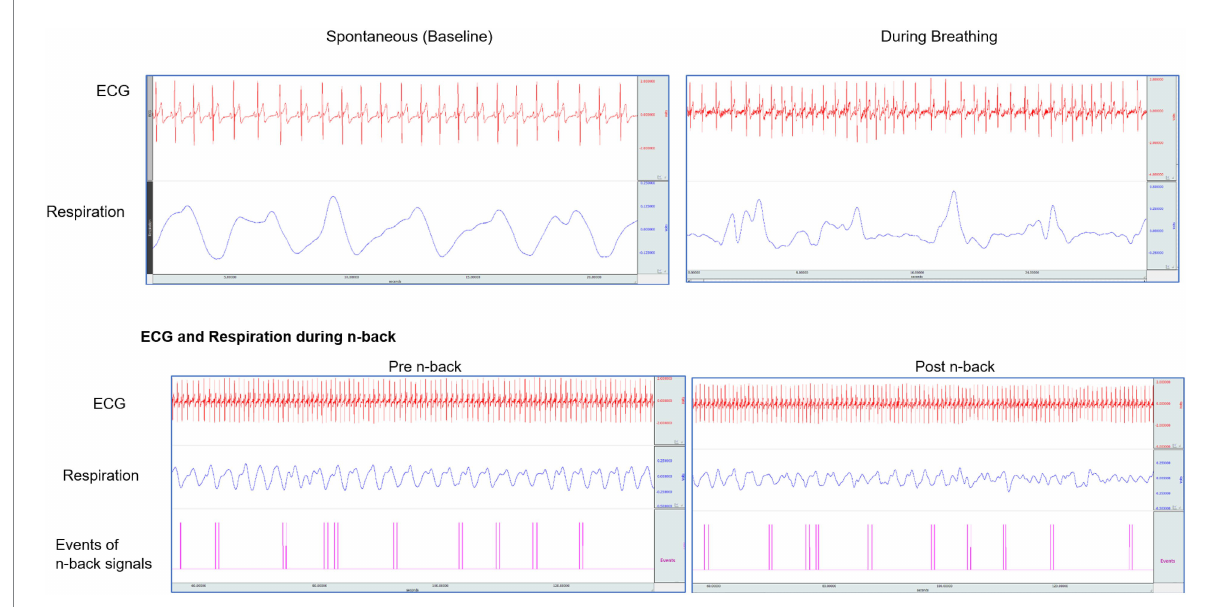
FIGURE 2 Original traces of ECG, respiration in one participant while breathing at their baseline, during slow yoga breathing, and in n-back task performance.